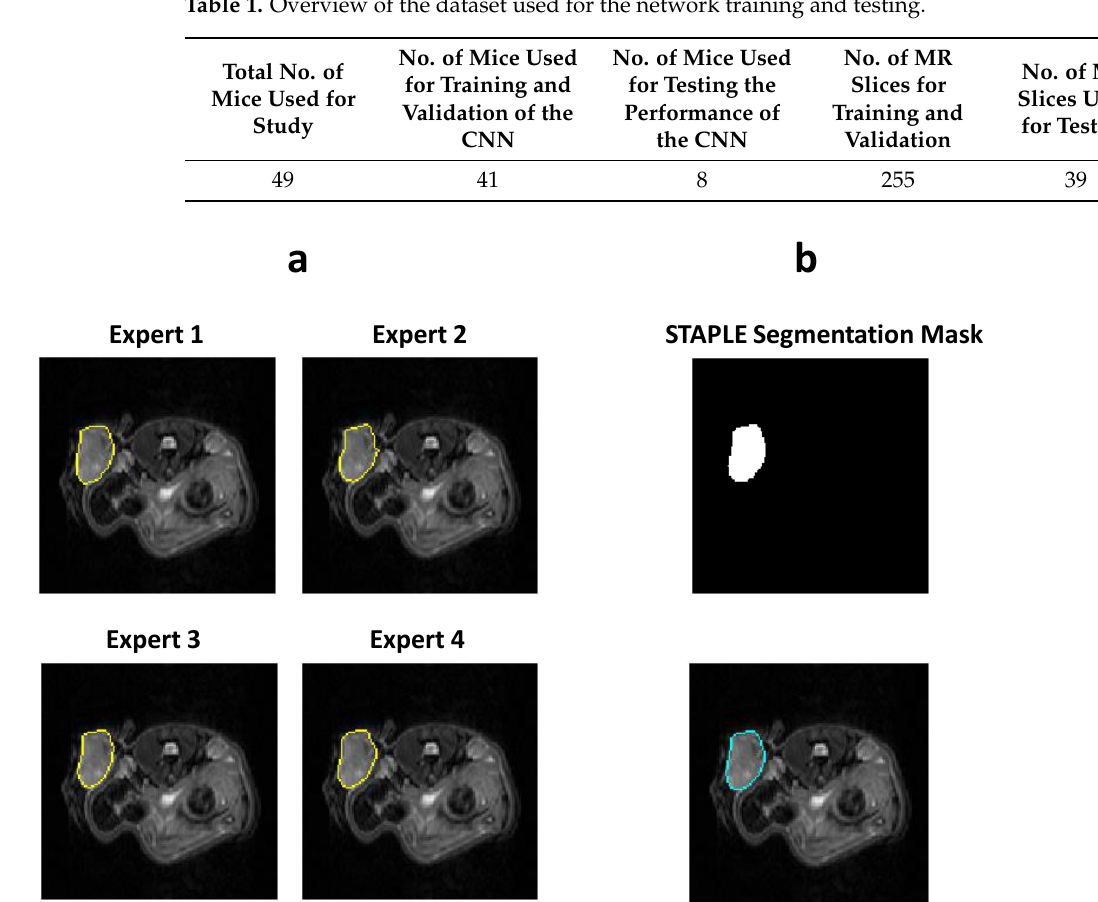
Figure 3. ( a ) Segmentation maps delineated by four manual experts, ( b ) segmentation map generated by applying the STAPLE algorithm to the manually delineated expert map represented in T2w image.